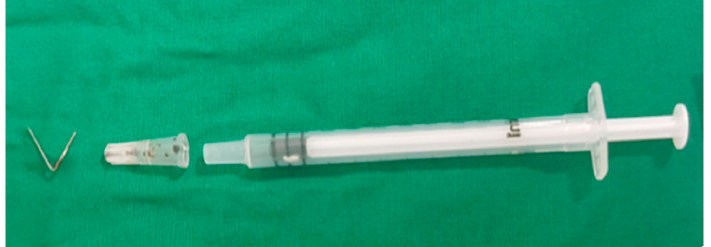
Figure 3. A piece of needle fragment retrieved from the groin and the used syringe. The bent needle while pulling it out with mosquito forceps.